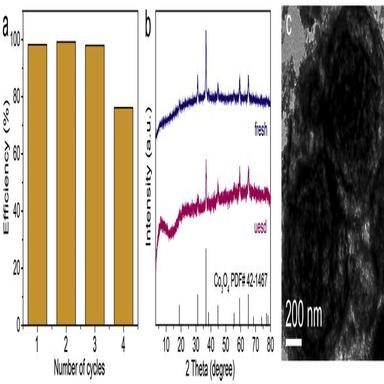
(a) The reusability test of the MS-VO-Co3O4 for catalytic 4-CP degradation (initial pH = 7.5). The characterizations of the spent MS-VO-Co3O4: (b) XRD pattern and (c) TEM image.